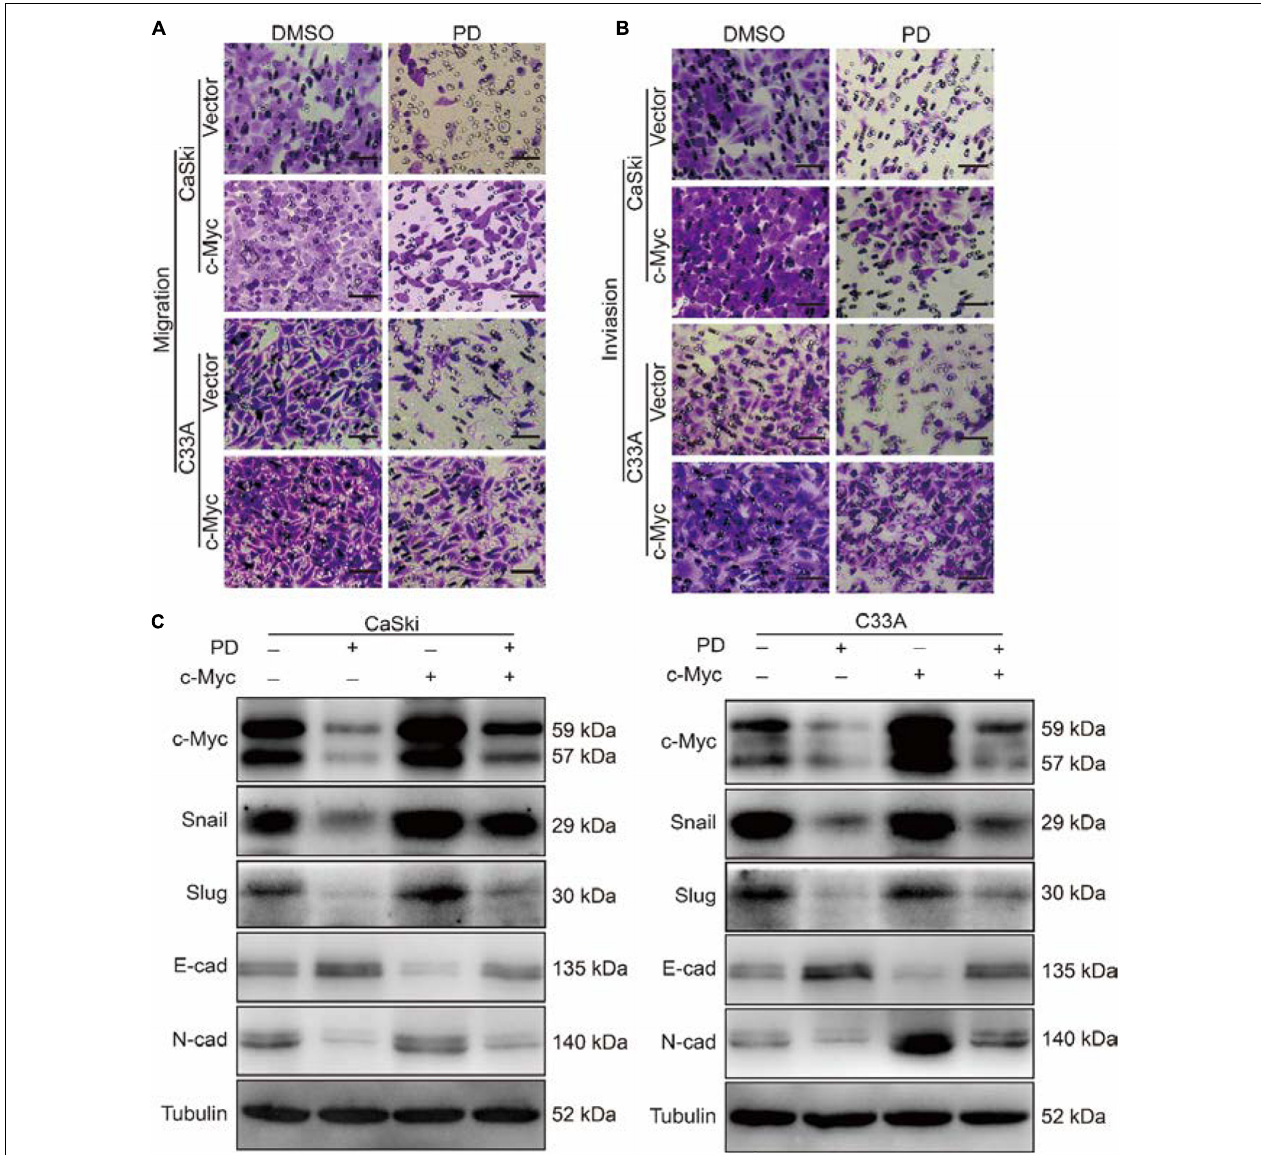
FIGURE 6 | The upregulation of c-Myc retrieved cell migration and invasion inhibited by polydatin. (A,B) The effect of the Transwell migration and invasion assays in c-Myc-overexpressed CaSki or C33A cells as well as vector cells after treating with dimethyl sulfoxide (DMSO) or 200 µ M of polydatin for 24 and 48 h. Scale bar, 100 µ m. (C) Western blot assays were used to show the expression of epithelial–mesenchymal transition (EMT)-related proteins in c-Myc-overexpressed CaSki and C33A cells as well as vector cells after being treated with DMSO or 200 µ M of polydatin for 48 h. Tubulin was used as a control. All data were analyzed using two-tailed Student’s tests. Error bars, ∗ P < 0.05, ∗∗ P < 0.01, and ∗∗∗ P <